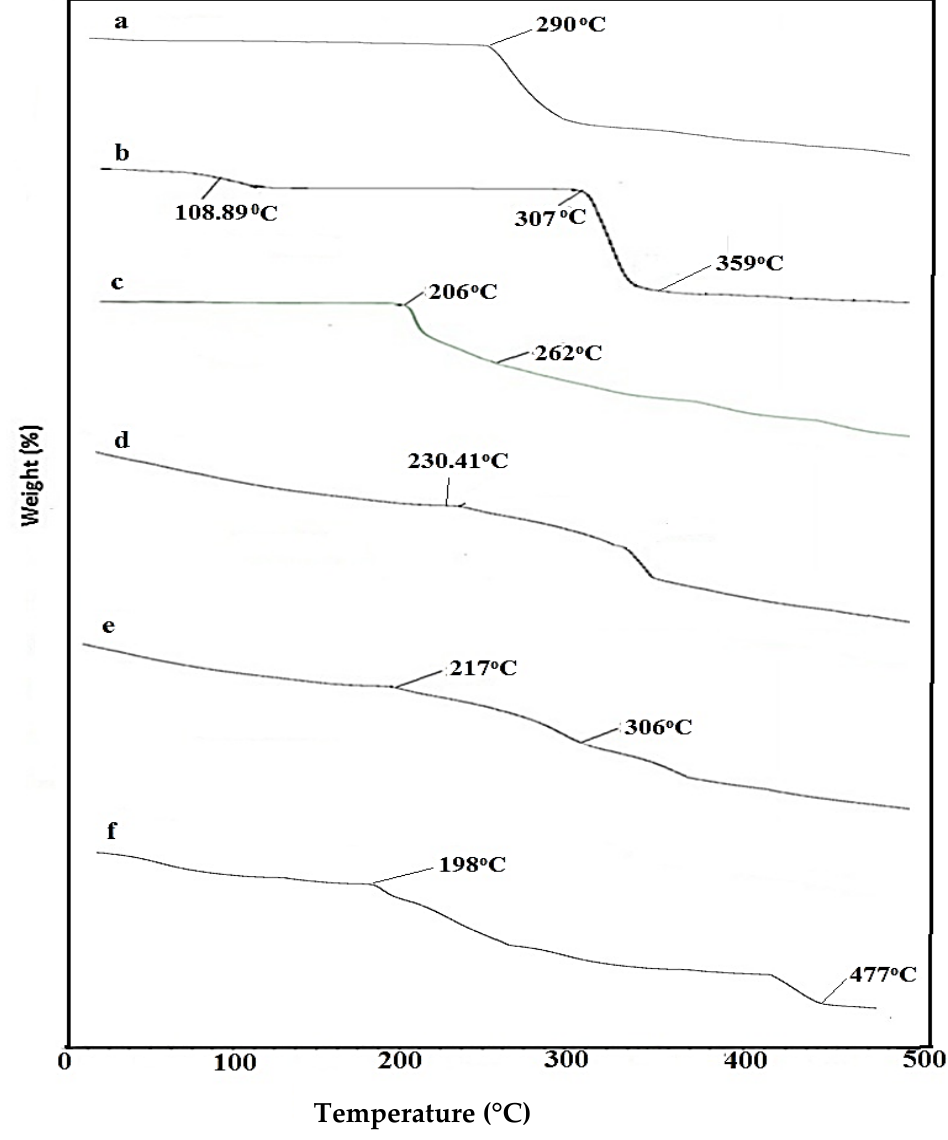
Figure 3. TGA thermogram of ( a ) Carboxymethyl chitosan (CMC), ( b ) β -CD, ( c ) AMPS, ( d ) physical mixture, ( e ) βCD -co-poly. (AMPS), and ( f ) βCD -CMC-co-poly (AMPS) nanosponges.